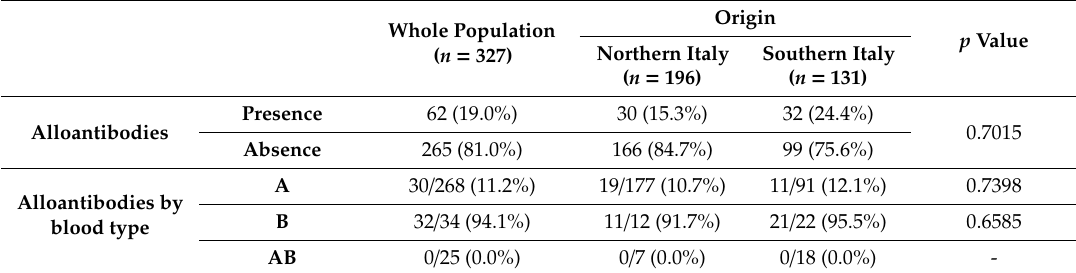
Table 3. Alloantibody prevalence of AB blood group system in cats from regions in Northern (Lombardy) and Southern (Sicily)